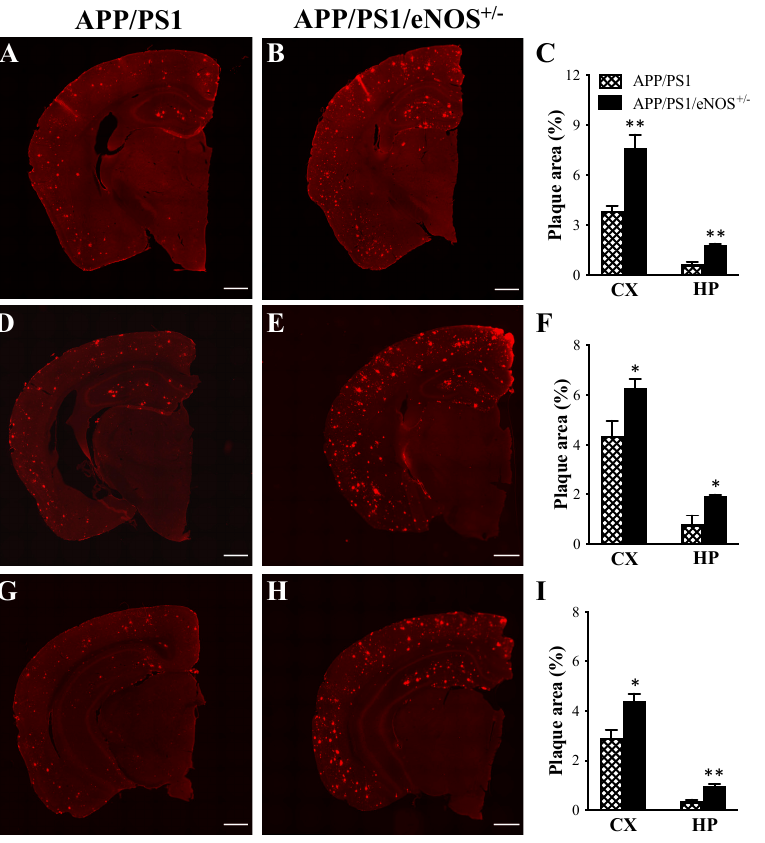
Figure 4. The representative 6E10 immunofluorescent coronal half-brain images of 8-months old male APP/PS1 ( A , D , G ) and APP/PS1/eNOS +/ − mice ( B , E , H ) at the levels of AP − 1.70 ( A , B ), − 2.30 ( D , E ) and − 2.92 ( G , H ) mm (scale bar 600 µm). Mean (± SEM) percentage area of 6E10-positive staining (plaque area) in the cortex (CX) and hippocampus (HP) at the levels of AP − 1.70 ( C ), − 2.30 ( F ) and − 2.92 ( I ) mm in APP/PS1 and APP/PS1/eNOS +/ − mice ( n = 5–6/genotype). * indicates a significant difference between groups at * p < 0.05 or ** p < 0.01.